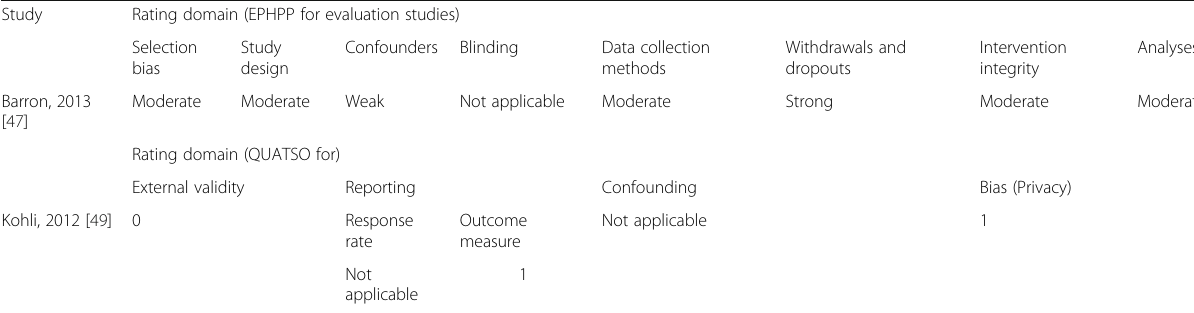
Table 3 Methodological quality rating of quantitative studies